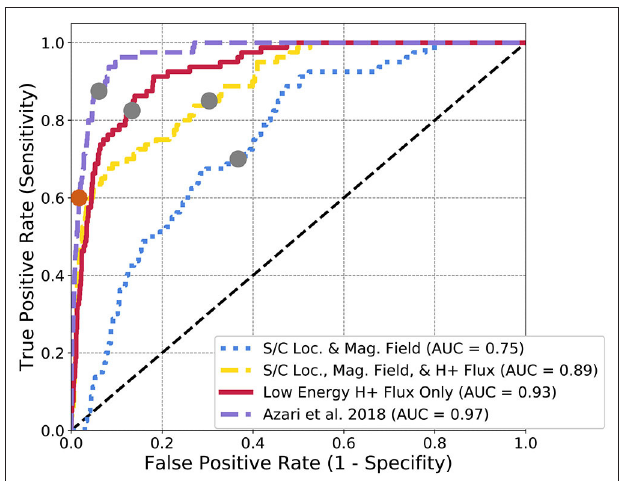
FIGURE 5 | Logistic regression ROC diagram for Cassini data subsets. The gray dots represent the cut-off for L2 regularization for logistic regression. The orange dot represents the peak HSS value, used for optimization in Azari et al. (2018). The distinct curves represent separate ROC curves for each subset of data described in section 4. The Azari et al. (2018) subset denotes the usage of S